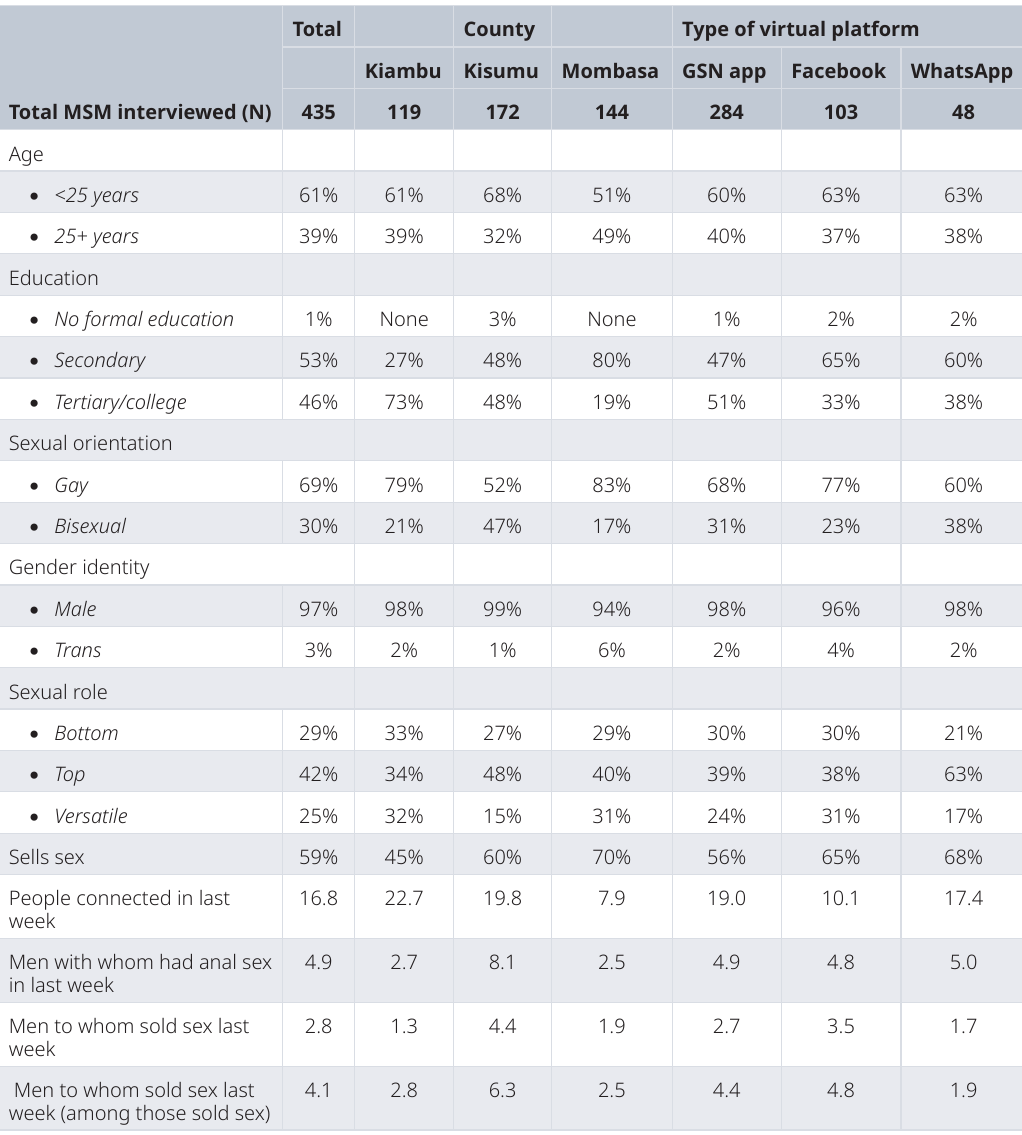
Table 3. Socio-demographic, sexual & network related characteristics of MSM operating through virtual platforms in selected counties in Kenya,